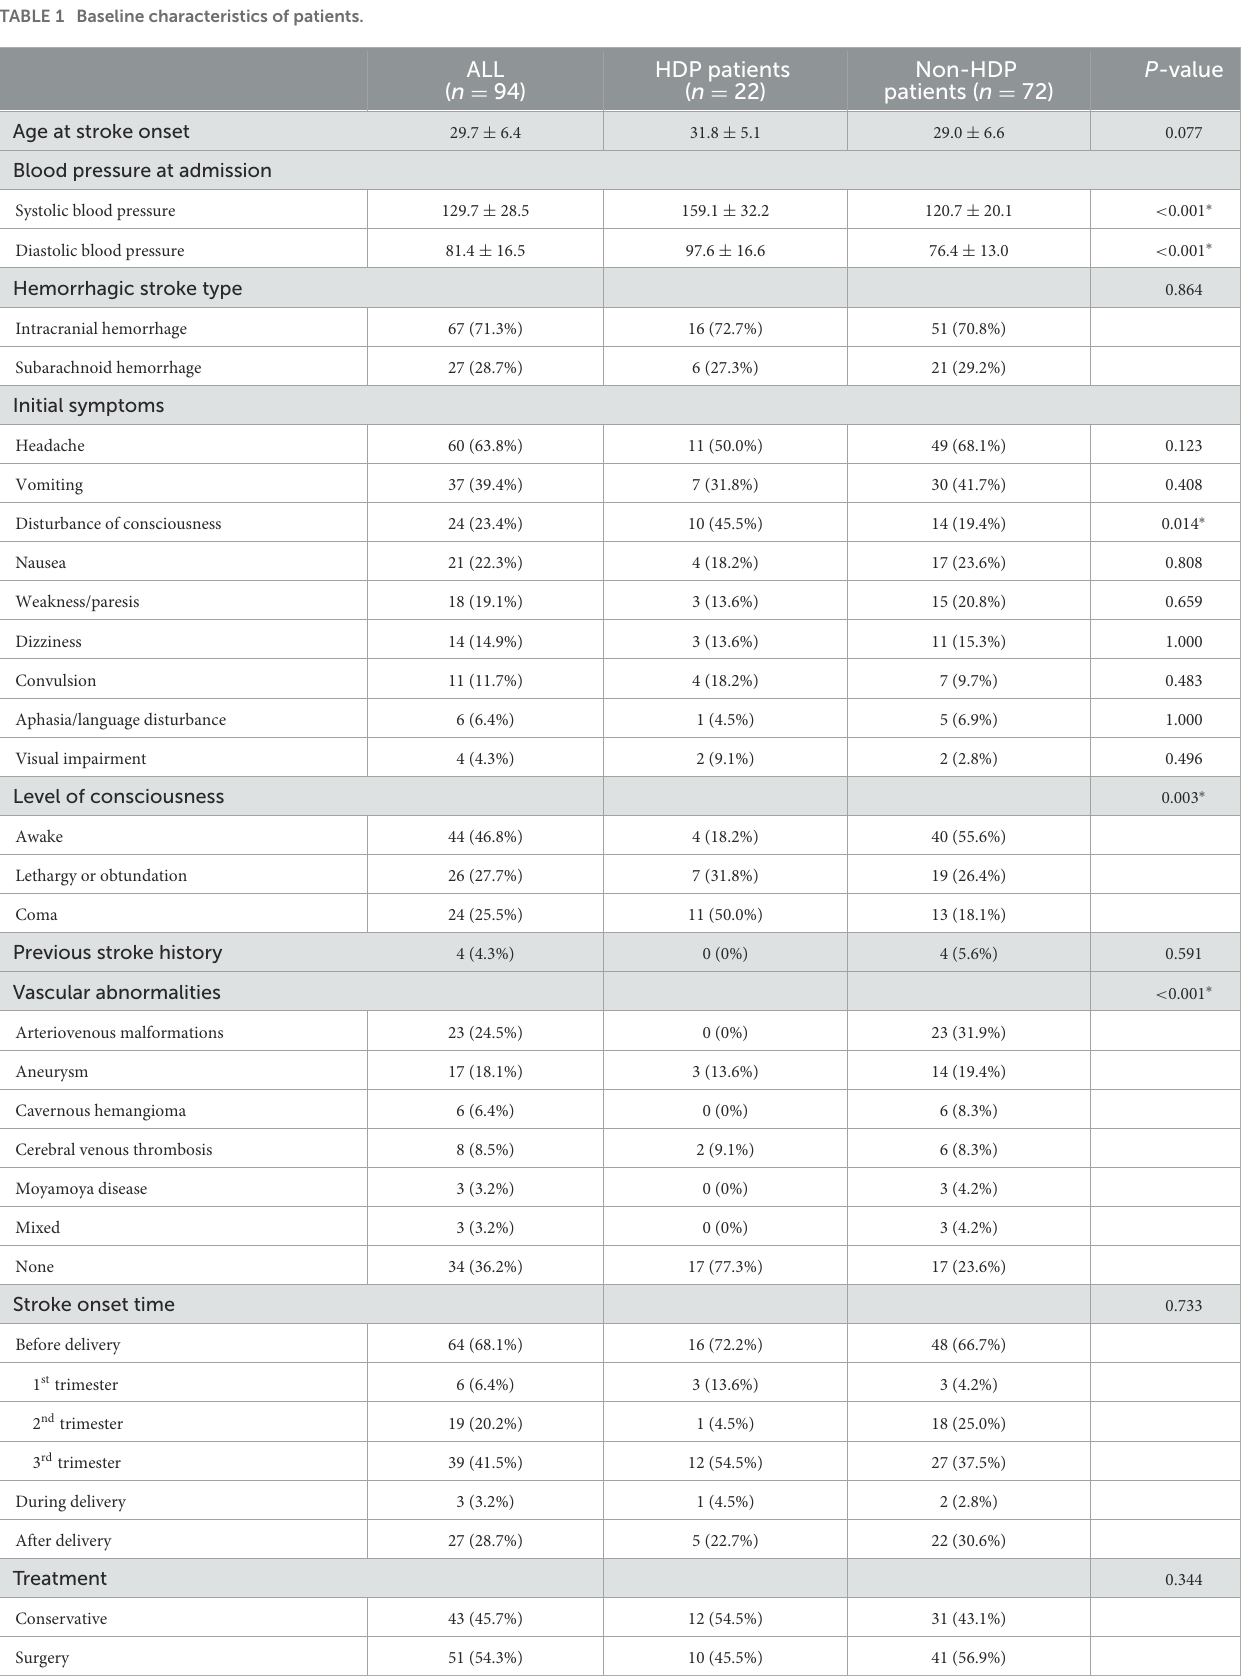
TABLE 1 Baseline characteristics of